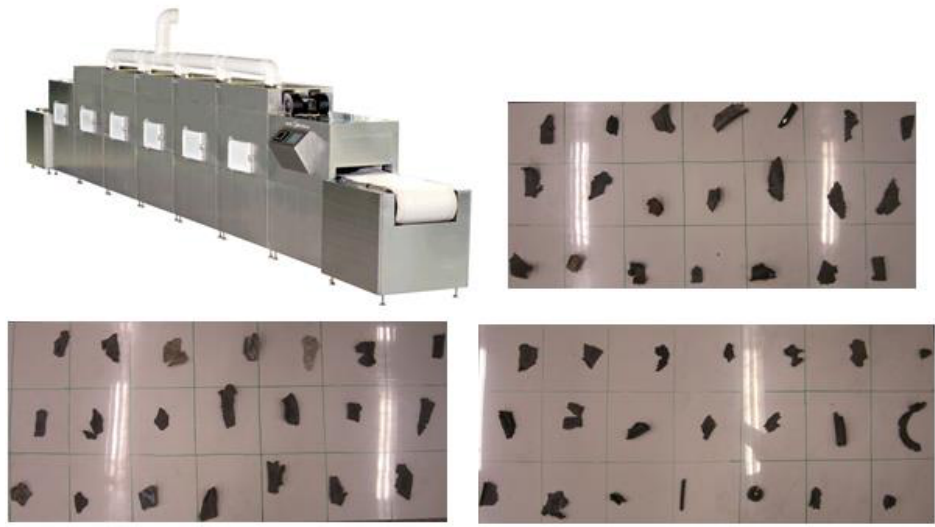
Figure 5. Installation of conveyor microwave facility and the tests of polymer scraps.